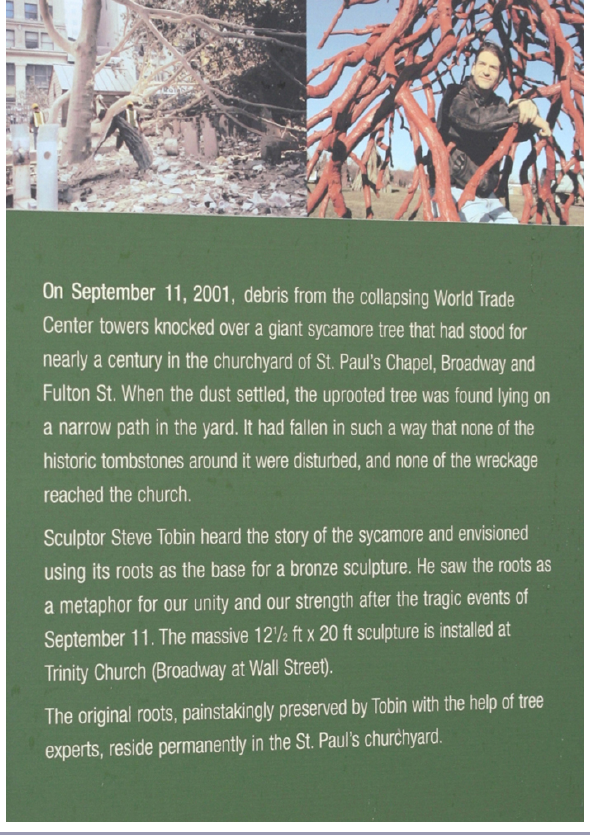
Fig. 1 . Interpretive sign near “Ground Zero” serves as example of tree symbolism in the form of repurposing dead and downed trees in the wake of disaster, alluding to the hybrid nature of tree symbols. Photo: K. G. Tidball.